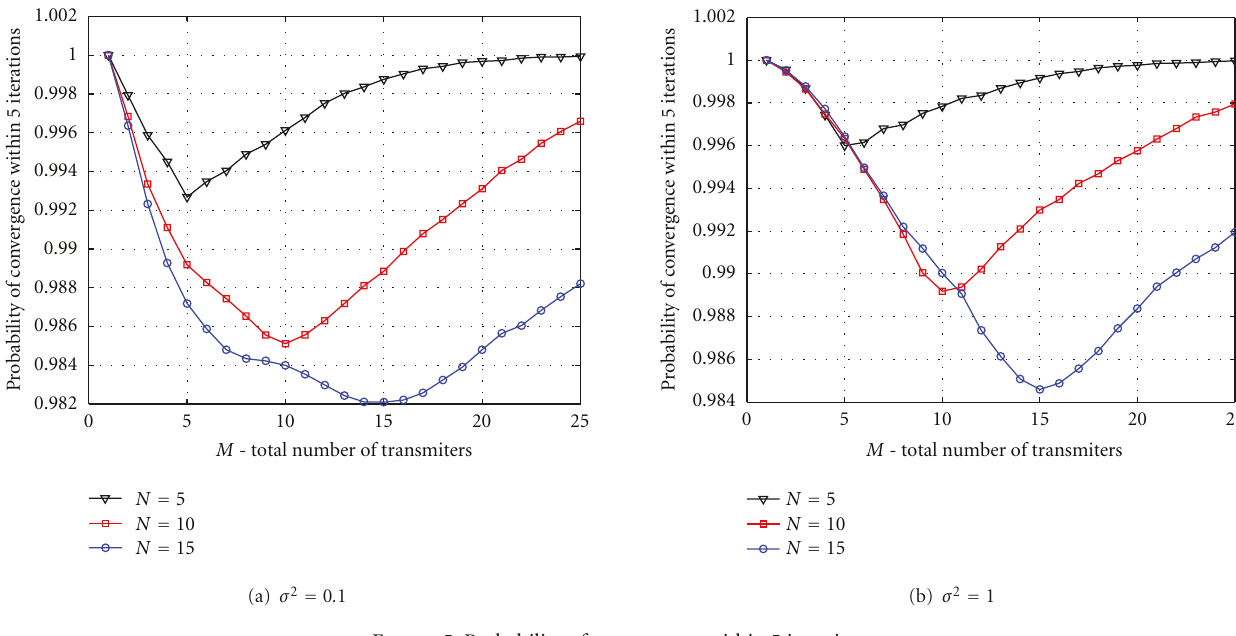
Figure 5: Probability of convergence within 5